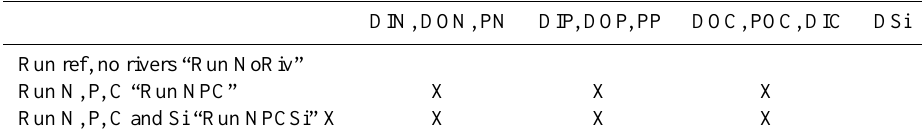
Table 2. Model runs, riverine nutrients inputs (TmolSiyr − 1 ).